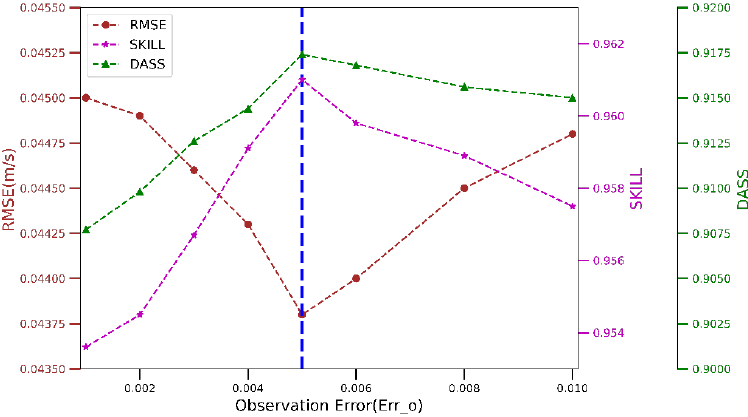
Figure 8. Observation error ( Err o ) versus RMSE, SKILL, and DASS of PF.